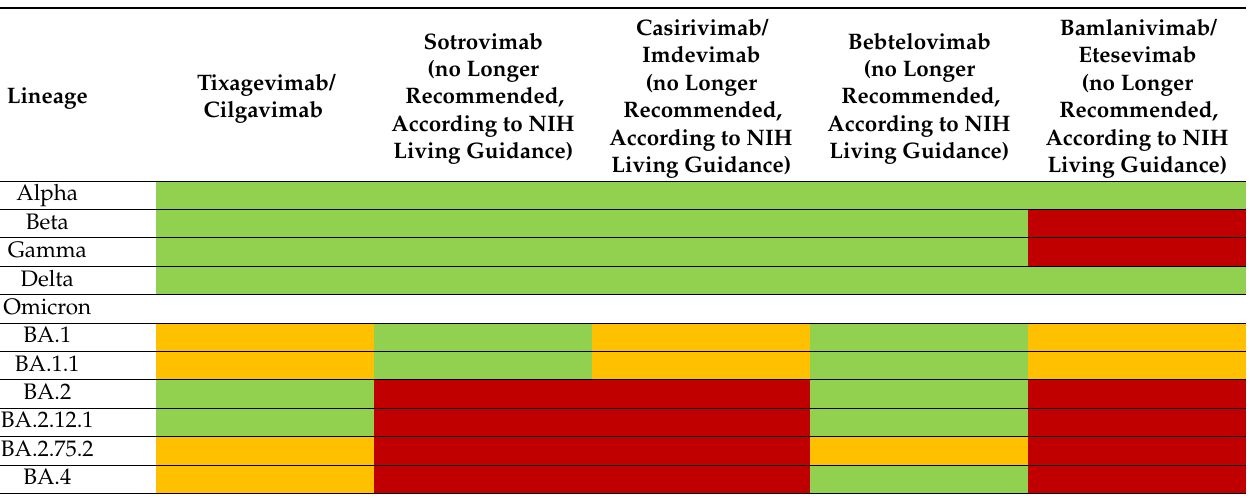
Table 1. Monoclonal antibodies approved for clinical use and the SARS-CoV-2 variant evasion of